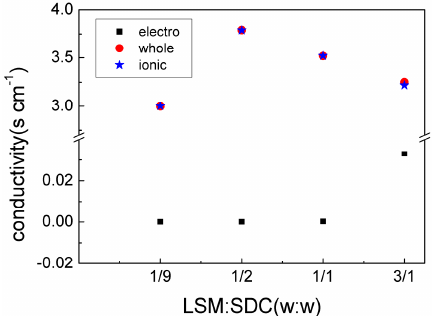
Figure 4. Conductivities for LSM-SDC (La 0.1 Sr 0.9 MnO 3 −δ -Ce 0.8 Sm 0.2 O 2 −δ ) composites with various compositions.